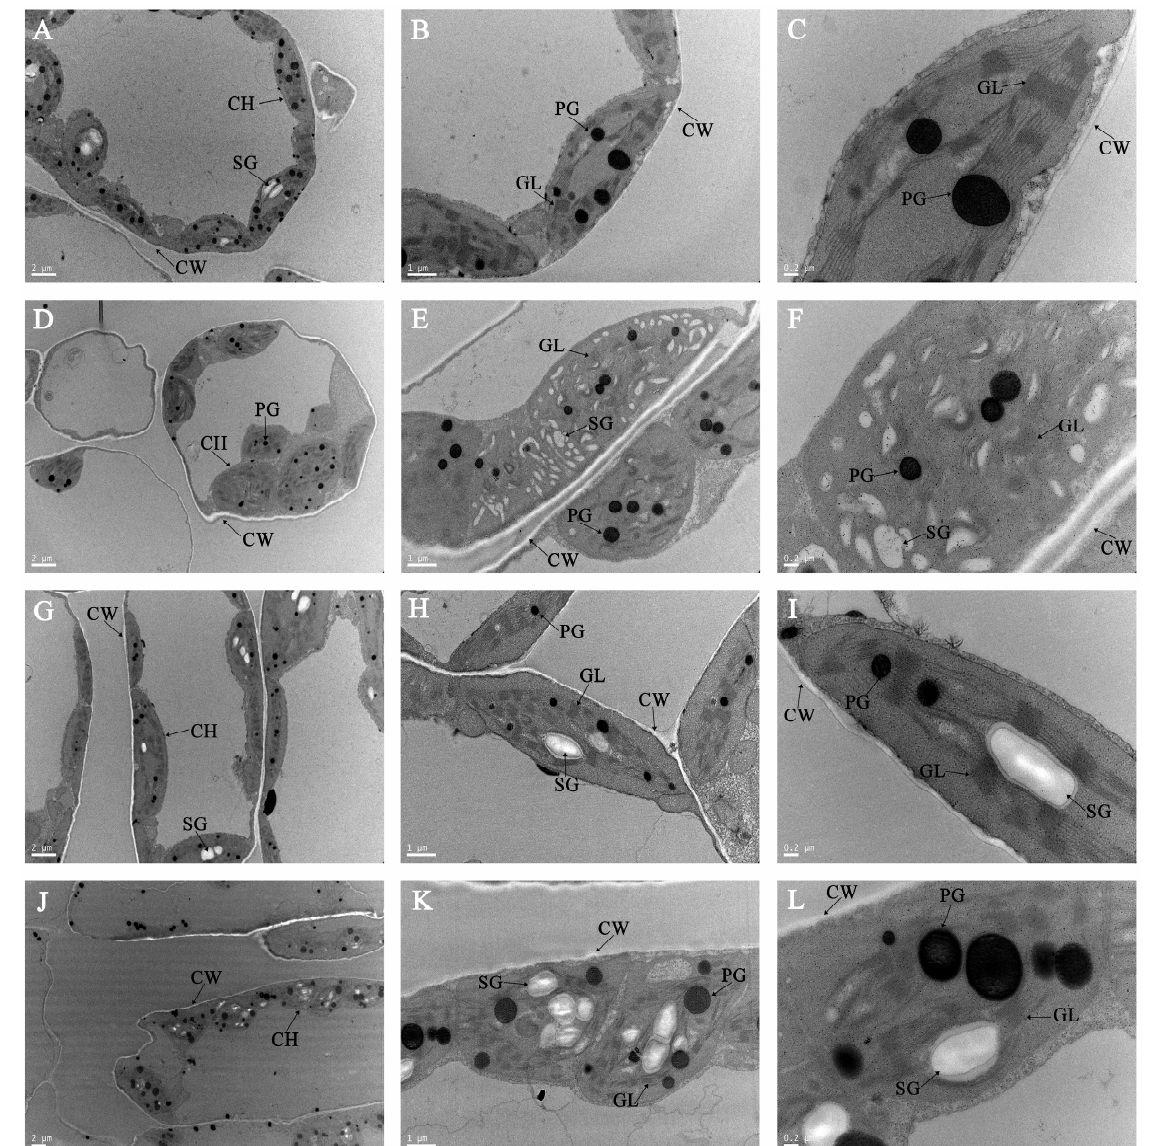
Figure 6. Transmission electron micrographs (TEM) of chloroplasts at low power microscope scales of 2 µ m, 1 µ m, or 0.2 nm at 3 days of HTH stress treatments and untreated seedlings (0 day) in melon seedings leaves. ( A – F ) represent the chloroplast ultrastructure of the ‘JIN TAI LANG’ variety under HTH stress at 3 days and untreated seedling (0 day), respectively; ( G – L ) represent the chloroplast ultrastructure of the ‘JIN DI’ variety under HTH stress at 3 days and untreated seedling (0 day), respectively. CH, chloroplast; CW, cell wall; SG, starch granule; GL, grana lamellae; PG, plastoglobule. Bars indicate 2 µ m, 1 µ m, and 0.2